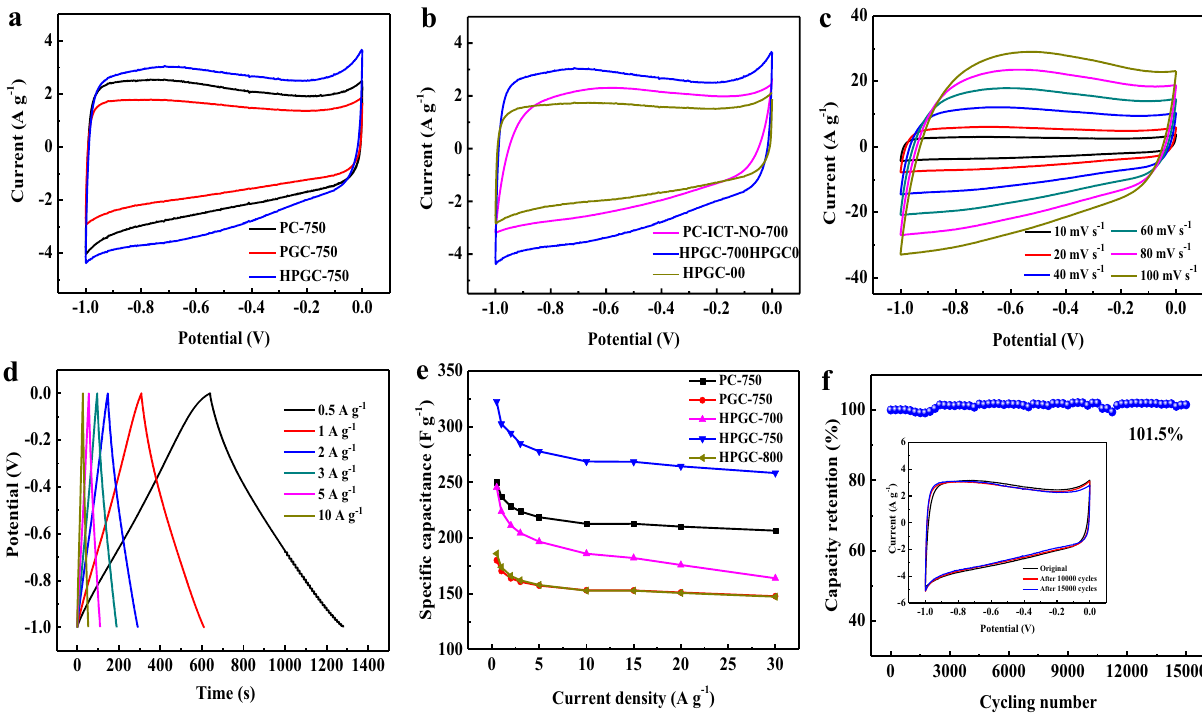
Figure 6. Electrochemical characteristics of a three-electrode system in 6 M KOH: ( a ) CV curves of PC-750, PGC-750, and HPGC-750 at 10 mV s −1 ; ( b ) CV curves of HPGC- T at 10 mV s −1 ; ( c ) CV curves of HPGC-750 at various scan rates from 10 to 100 mV s −1 ; ( d ) GCD curves of HPGC-750 under various current densities; ( e ) specific capacitances of all electrodes as a function of current density; ( f ) cycling stability of HPGC-750 for 15,000 cycles measured at 100 mV s −1 with inset showing CV curves at 10 mV s −1